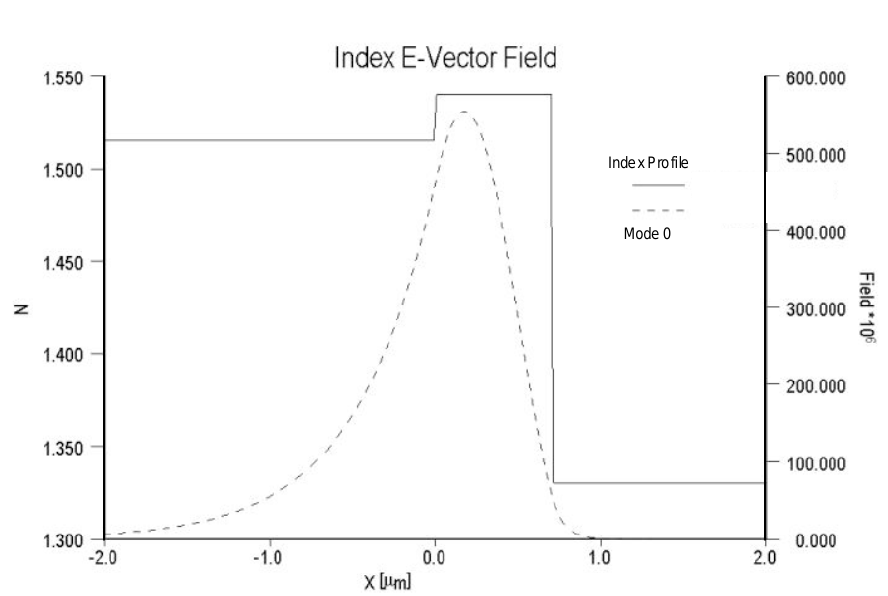
Figure 4. Electric field distribution for a low-contrast waveguide system.